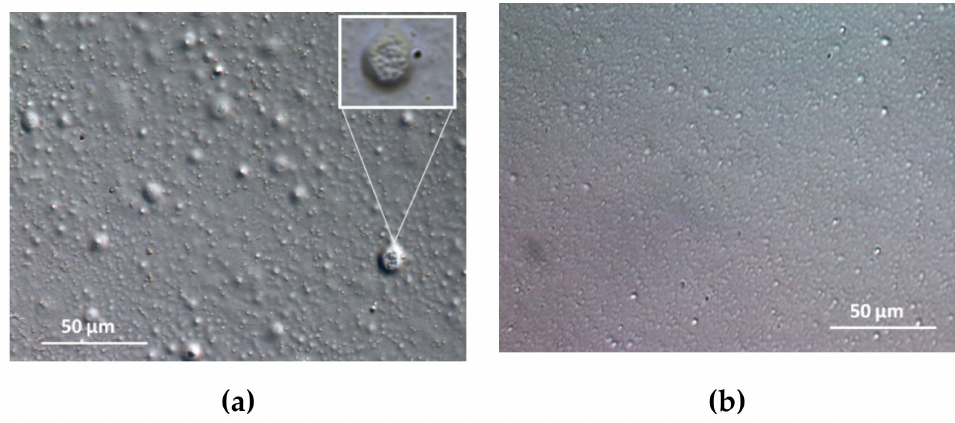
Figure 3. DIC (20 × ) optical microscopy images representing ( a ) LV-Zn and ( b ) LVC-Zn before dialysis. In the in vitro release determination, it can be noticed that the molar concentration of Zn released increased slowly over time, with a complete release from the LVC-Zn at 24 h (Figure 4).